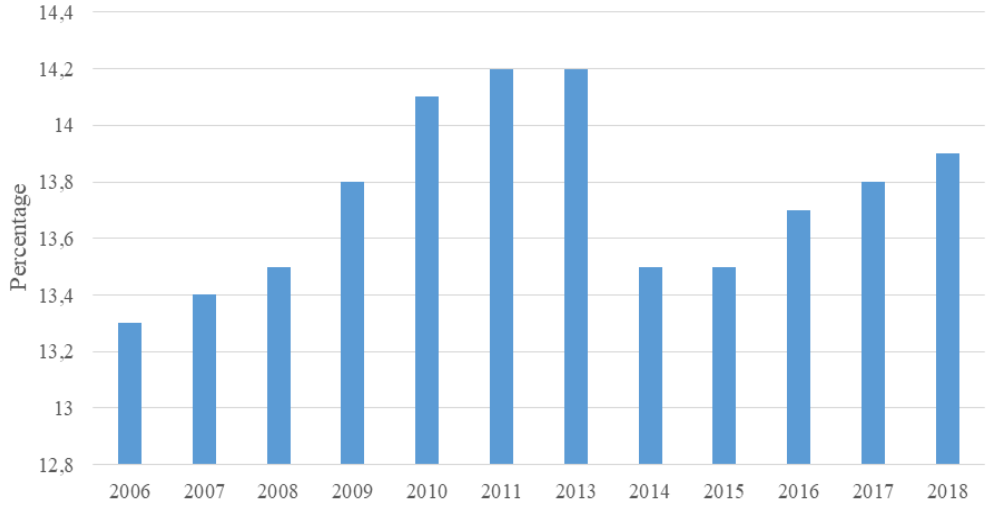
Fig. 3. Ratio of non-agricultural land to agricultural land (Source: GSO Vietnam) Table 1. Land cover change in Vietnam by main categories, 2007–2017 (Source: Author’s calculation from the pixel change